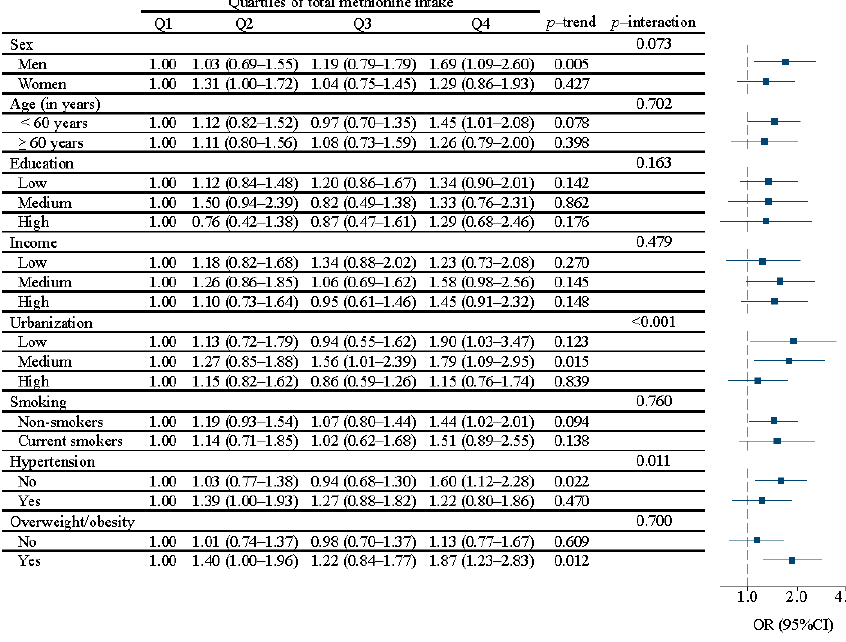
Figure 1. Subgroup analyses of the association between quartiles of total methionine intake and diabetes. Values are odds ratios with a 95% CI from mixed-effect logistic regression models. The model was adjusted for age, gender, energy intake, education, income, urbanization, smoking, alcohol drinking, and physical activity, dietary patterns, BMI, and hypertension. Q, quartile. Stratification variables were not adjusted in the corresponding models. A forest plot showing the associations between methionine intake in Q4 and diabetes in China.